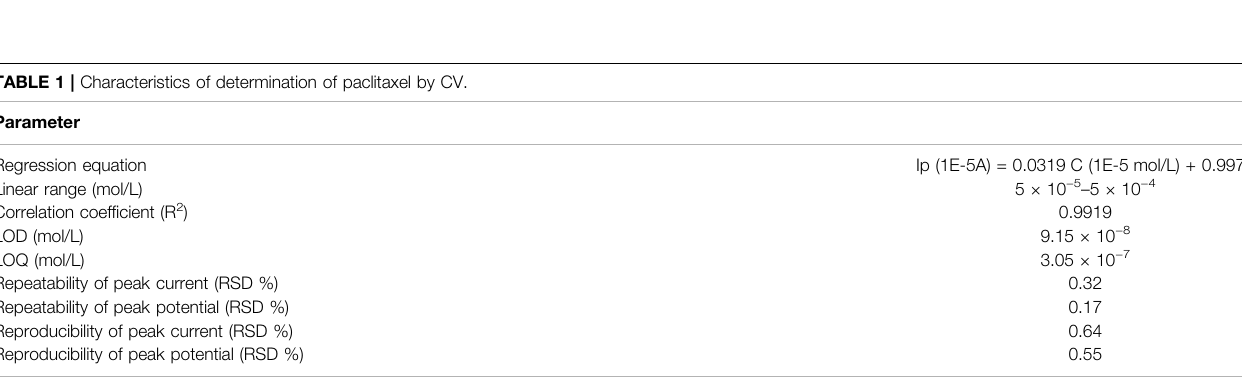
TABLE 1 | Characteristics of determination of paclitaxel by CV.